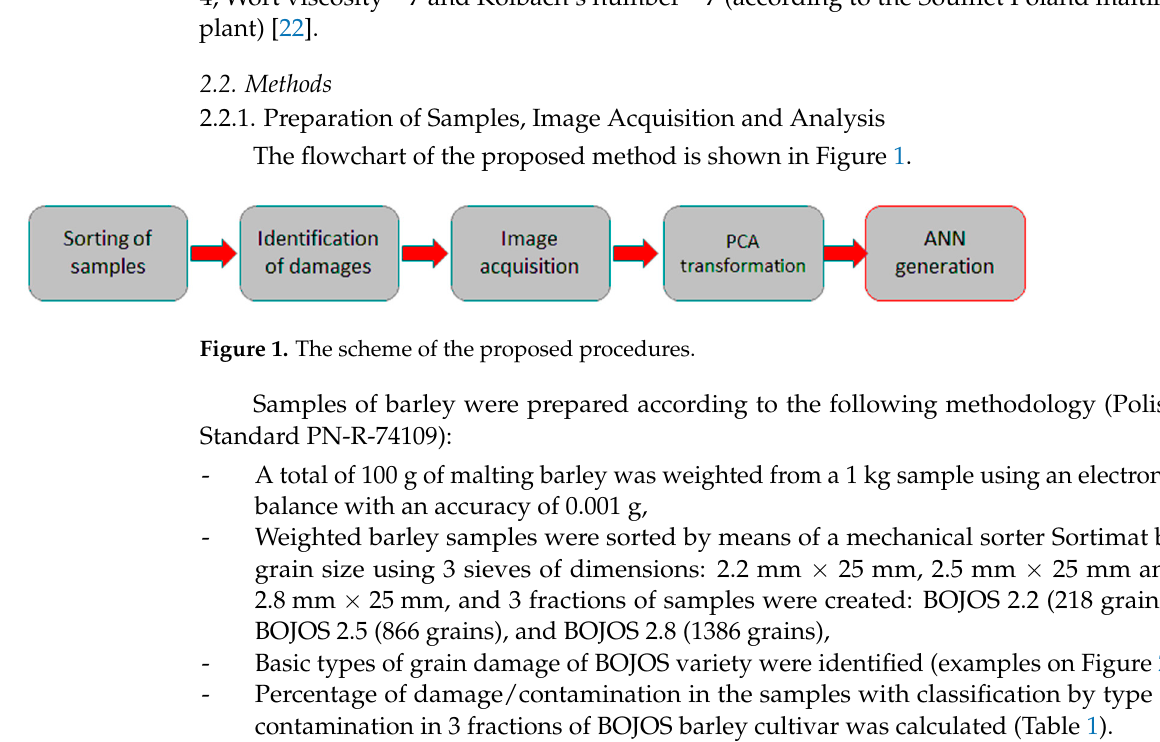
Figure 1. The scheme of the proposed procedures. Table 1. Contaminant content in the examined size fractions of malting barley of BOJOS variety [%]. Characteristics